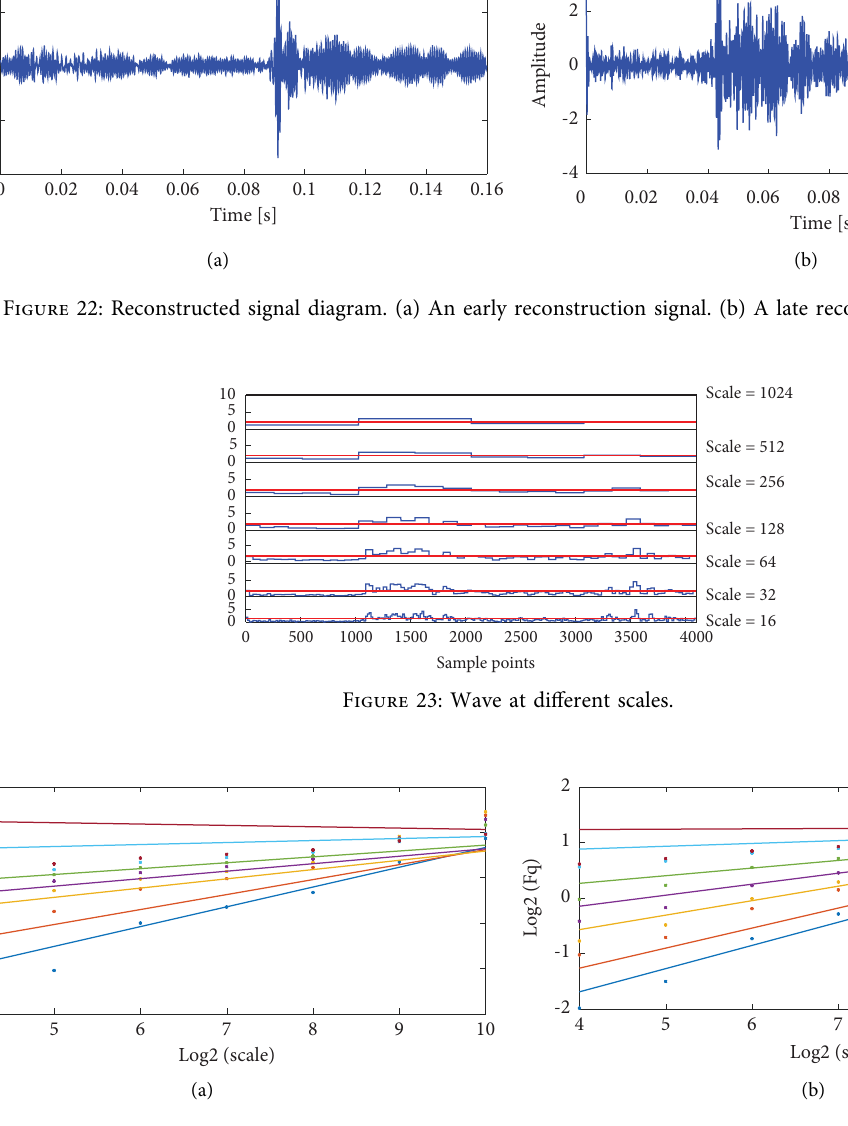
Figure 24: Logarithmic regression line of wave function and scale. (a) Early function. (b) Late